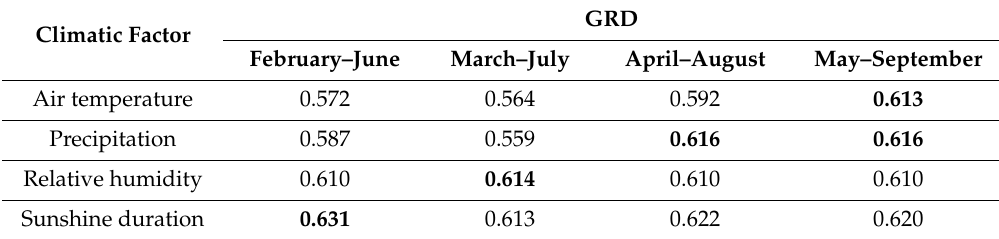
Table 2. The GRDs of NDVI in growing season to air temperature, precipitation, relative humidity